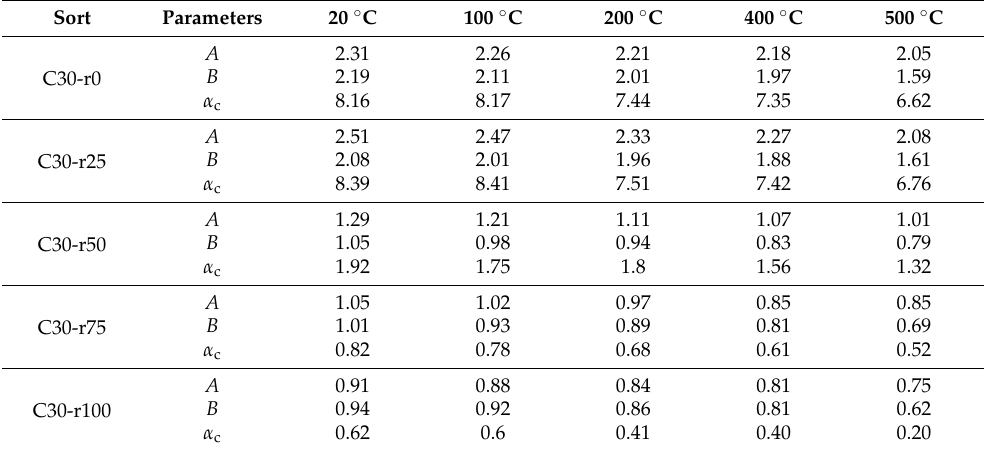
Table 6. Parameters of constitutive